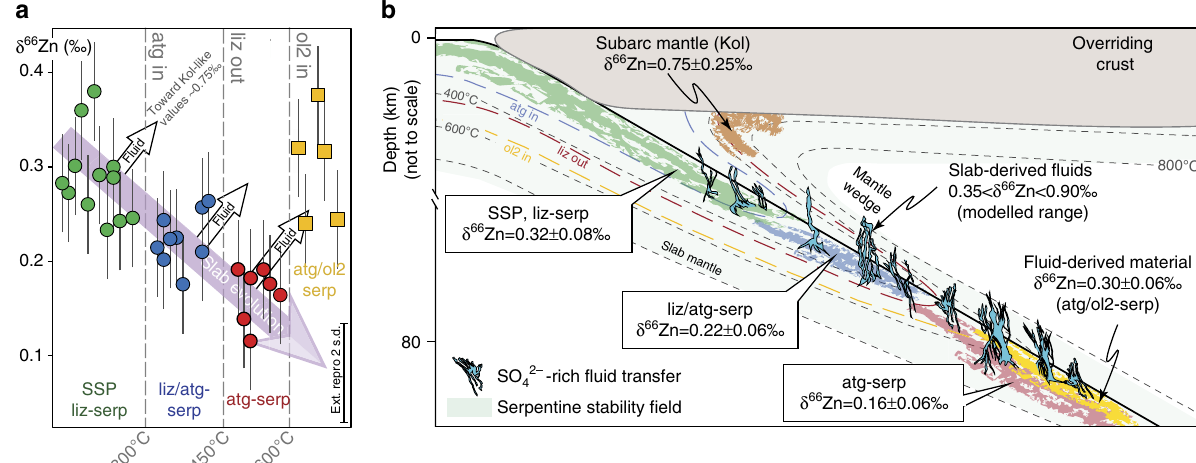
Figure 1 | d 66 Zn evolution of subducted serpentinites and release of a 66 Zn-enriched slab-derived fluid during subduction. ( a ) Evolution of d 66 Zn in serpentinites and peridotites from Western Alps ophiolites with respect to mineralogy and prograde metamorphic grade. The purple arrow shows the Zn isotopic evolution of the slab during subduction (serpentinites, circle markers). The white arrows show the inferred release of 66 Zn-enriched fluids during serpentinite devolatilization associated with the slab subduction and increasing metamorphic grade (atg/ol2-serp, yellow square markers). Sample error bars represent the 2 s.d. reproducibility of replicate analyses and a bold error bar is also shown on all plots indicating the external reproducibility (2 s.d.) of rock standards, from dissolution through to mass spectrometry analysis. Sample abbreviations: SSP, slightly serpentinized peridotites (almost completely unmetamorphosed, green dots), liz (lizardite serpentinites, greenschist facies, green dots), liz/atg (lizardite-antigorite serpentinites, blueschist facies, blue dots), atg (antigorite serpentinites, eclogite facies, red dots); atg/ol2-serp (antigorite and secondary olivine-bearing serpentinites, eclogite facies), Kol: Kohistan Arc gem olivines. ( b ) Schematic diagram illustrating the behaviour of Zn isotopes in serpentinites during subduction and the transfer of a 66 Zn-enriched sulfate-rich, slab-derived fluid to the mantle wedge. The boxes display the average d 66 Zn ( ± 2 s.d.) of the slab serpentinites. These means are statistically distinguishable (Student’s t -test, two-tailed, 95% C.I.). The green, blue and red shaded regions of the subducting slab indicate the hypothetical locations of the studied serpentinite samples in this setting. The yellow shaded regions denote the inferred location of the atg/ol2- serpentinites, and associated veins derived from slab fluids. Light blue fluid patterns: transfer of 66 Zn-enriched, sulfate-rich fluids across the subduction zone. Grey dashed curves: isotherms. Blue dashed line: appearance of antigorite. Red dashed line: instability limit of the lizardite. Yellow dashed line: appearance of secondary